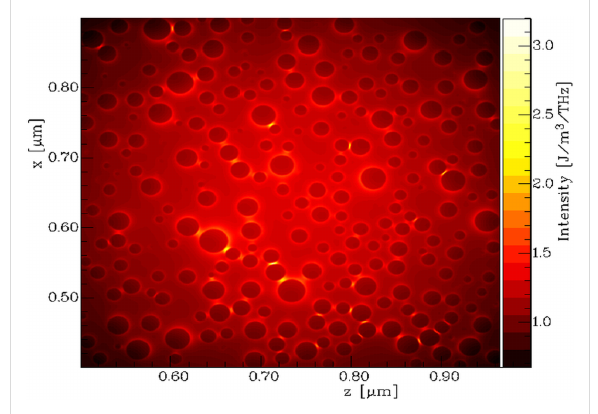
Figure 13: Calculated intensity distribution of the electromagnetic field with unpolarized incident light of a wavelength of 395 nm, integrated 10 nm above the Si